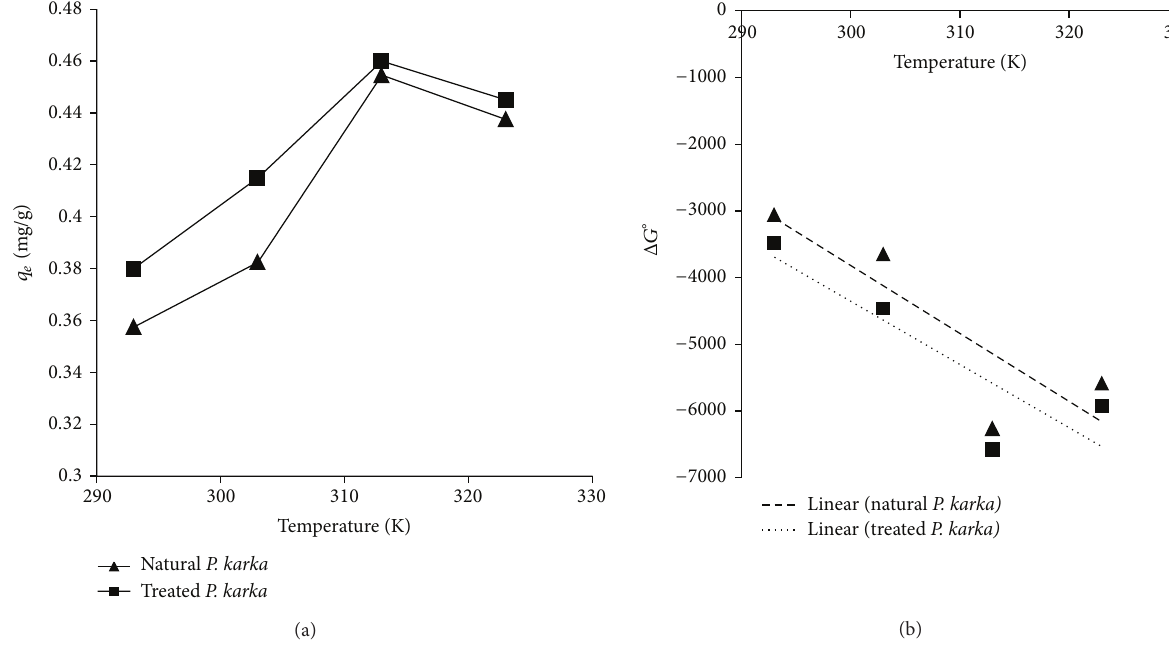
Figure 10: (a) Effect of temperature on adsorption capacity of natural P. karka and treated P. karka . (b) Thermodynamics studies for natural P. karka and treated P. karka (concentration = 10 mg/L, time = 50 and 40 minutes for natural P. karka and treated p. karka , resp., 𝑇 = 298 –328 K, agitation speed = 150 and 100rpm natural P. karka and treated p. karka , resp., dose of biosorbent = 1g/100mL, and pH = 6 and 7 for natural P. karka and treated p. karka , resp.).